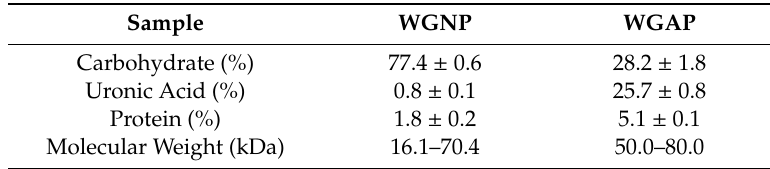
Table 1. Chemical composition and average molecular weight of white ginseng neutral polysaccharide (WGNP) and white ginseng acidic polysaccharide (WGAP).